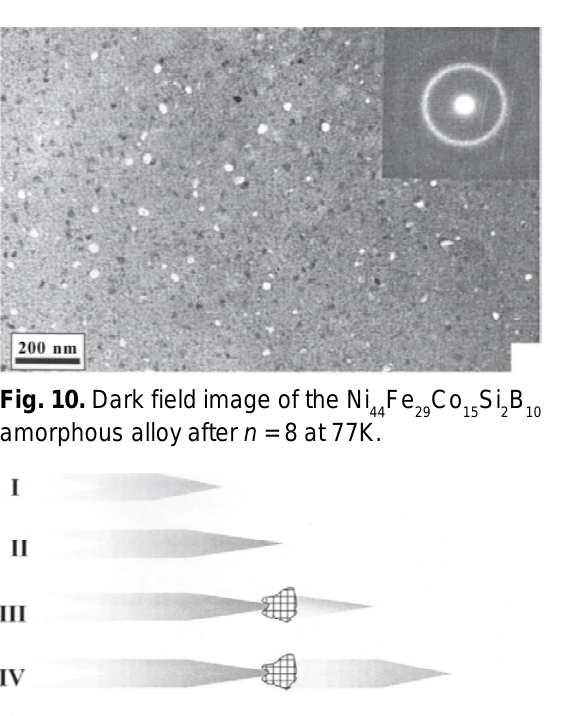
Fig. 11. The mechanism of “self-blocking” of shear bands propagating in the amorphous matrix.